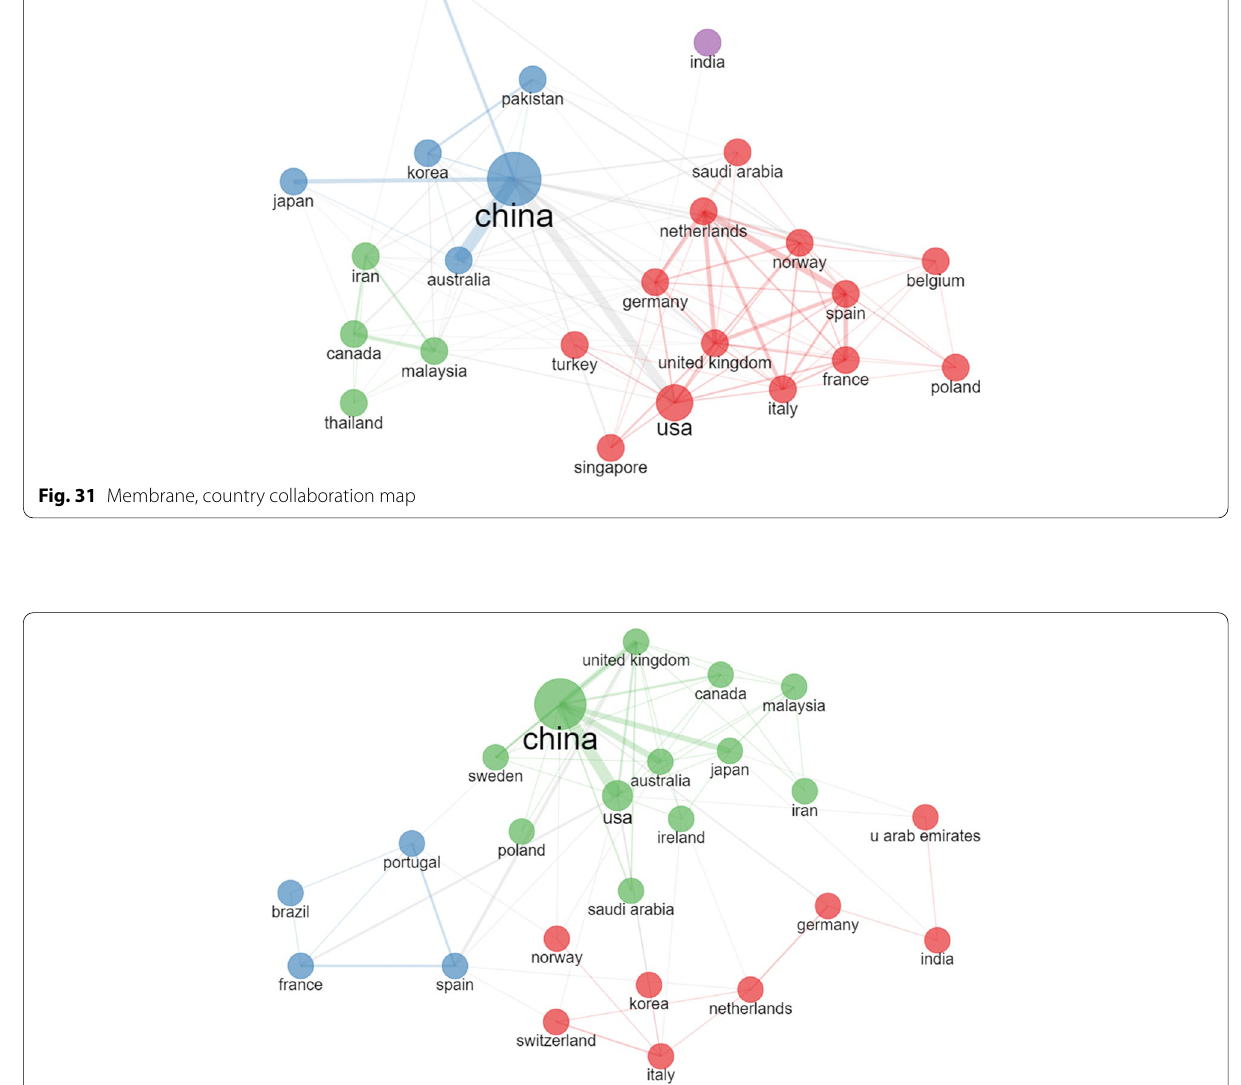
Fig. 32 Hybrid, country collaboration